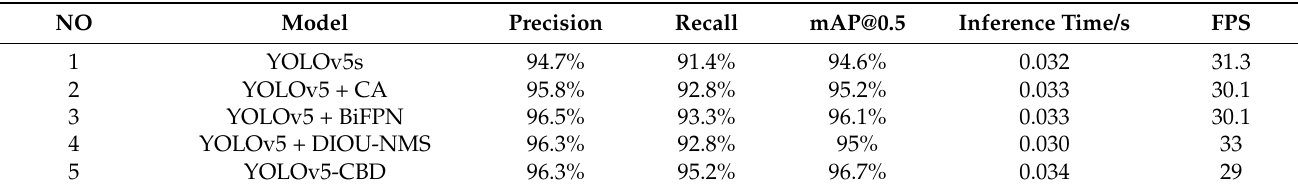
Table 5. Results of ablation experiments.